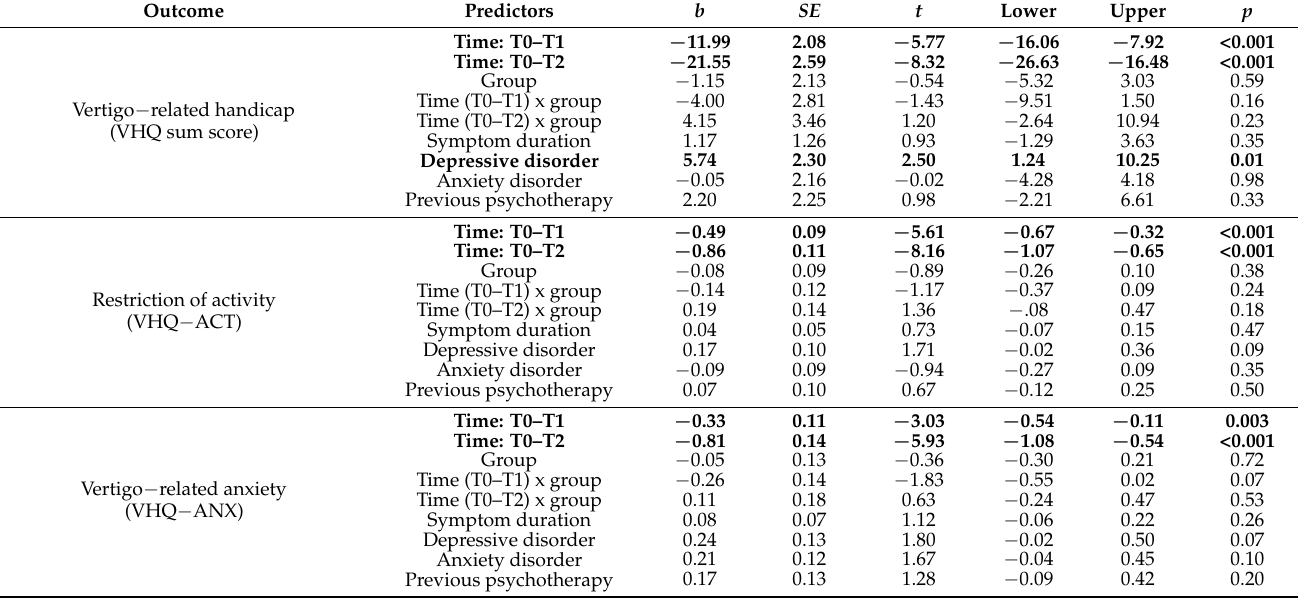
Table 4. Results of the linear mixed model